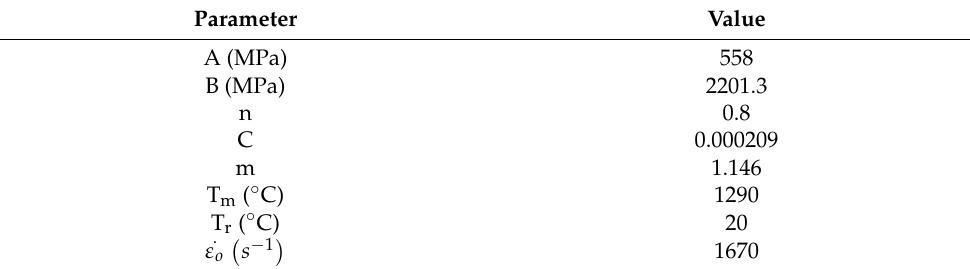
Table 4. Johnson–Cook plasticity parameters